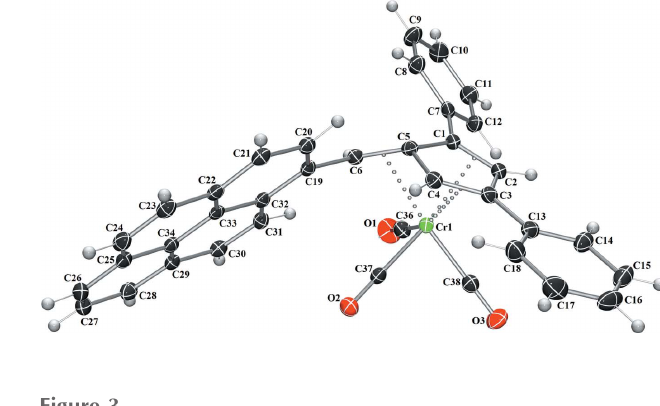
Figure 1 The molecular structure of I . Displacement ellipsoids are shown at the 50% probability